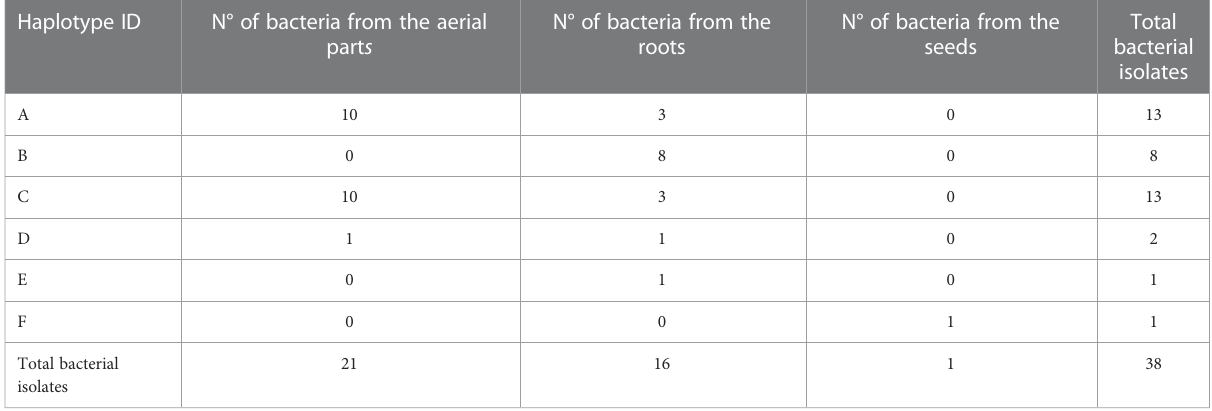
TABLE 1 ARDRA screening results on the 38 bacterial isolated